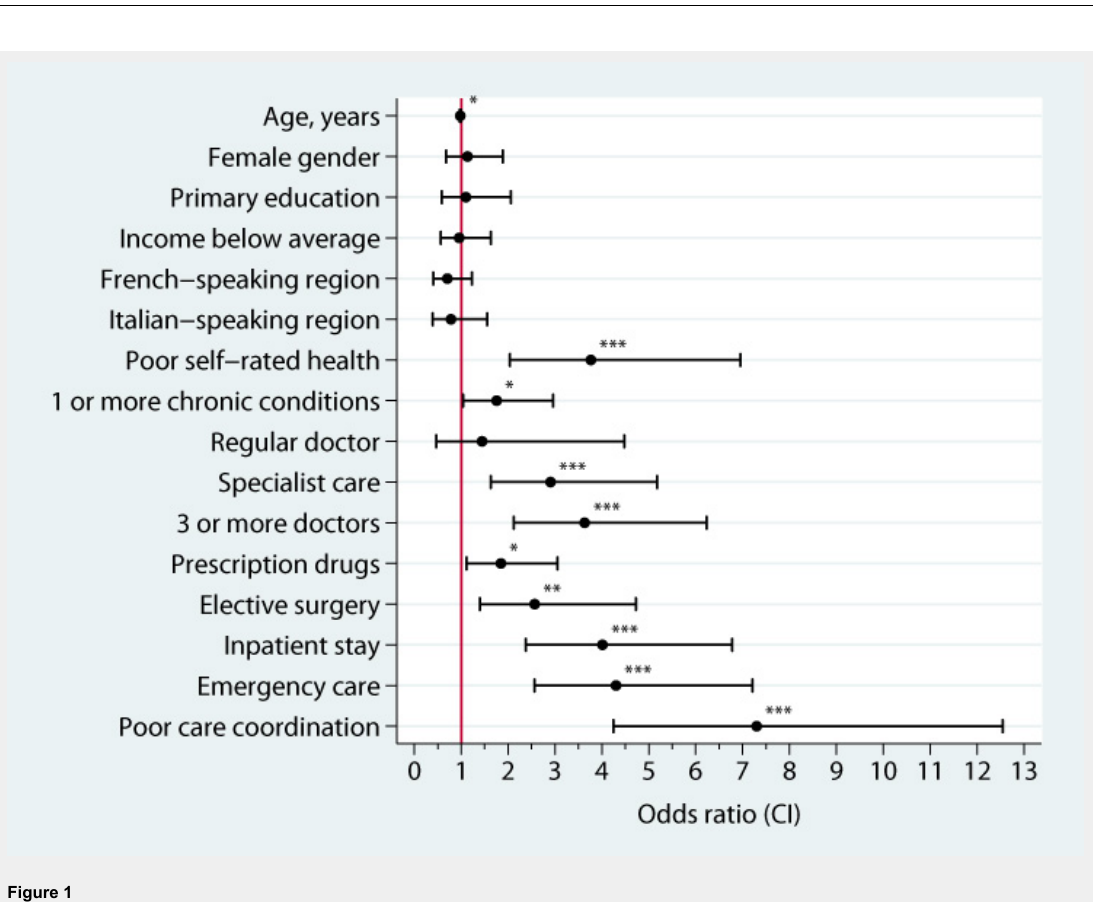
Figure 1 Bivariate associations between demographic, health and health care utilisation variables and report of any medical or medication error among Swiss respondents, weighted data. Stars indicate significant associations (*p <0.05; **p <0.01; ***p